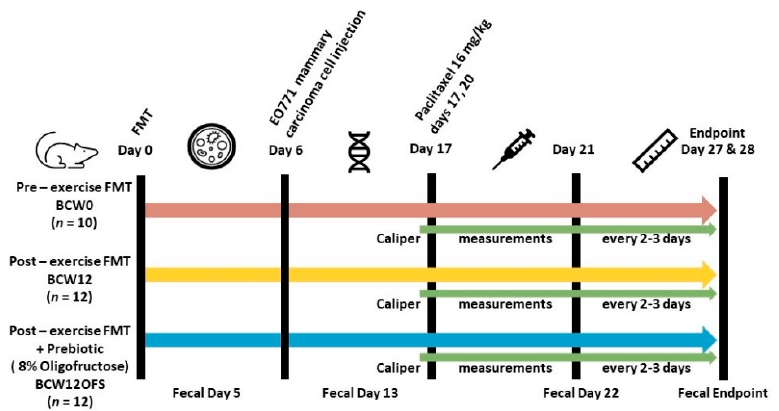
Figure 2. Murine Study Schematic.